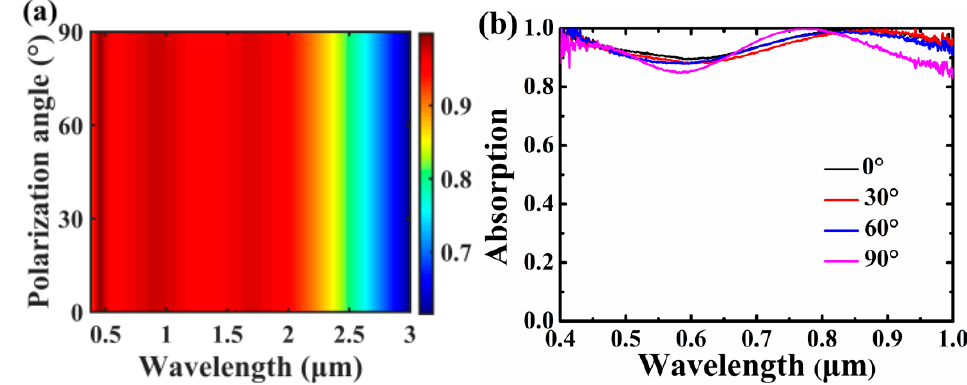
Figure 6. Absorption spectra of the Cr-based MA under the variation of polarization angle. Other parameters are kept the same as Figure 1a. ( a ) Theoretical absorption 2D map as a function of polarization angle. ( b ) Measured absorption spectra as a function of polarization angle.